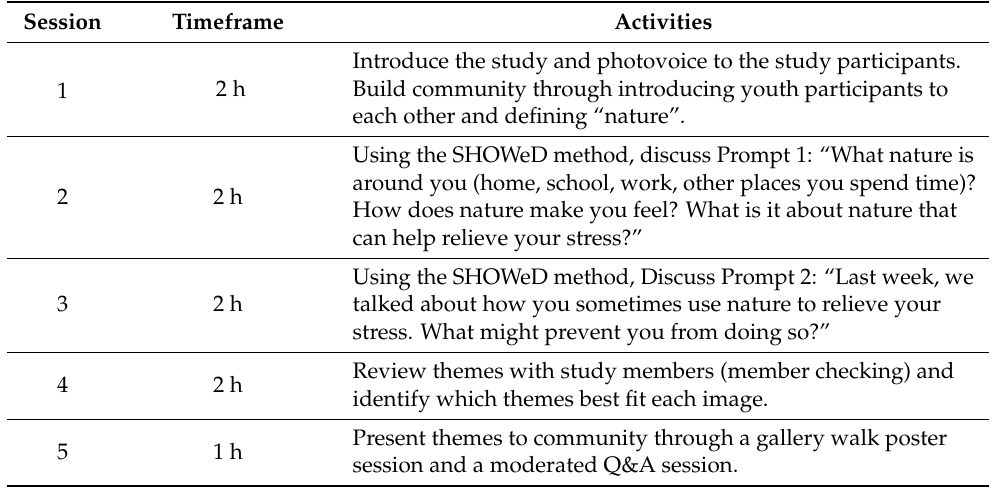
Table 1. Description of photovoice